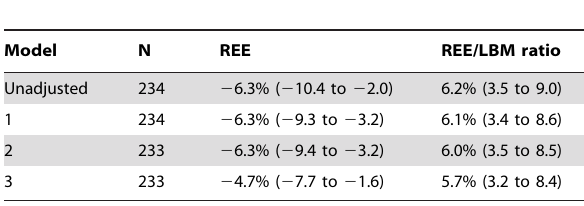
Model 1: Adjusted for age and sex, Model 2: Adjusted for 1 + parental education (4 levels) and daily smoking, Model 3: Adjusted for 2 + body fat percentage and the self-reported intensity, frequency and duration of leisure time physical activity.